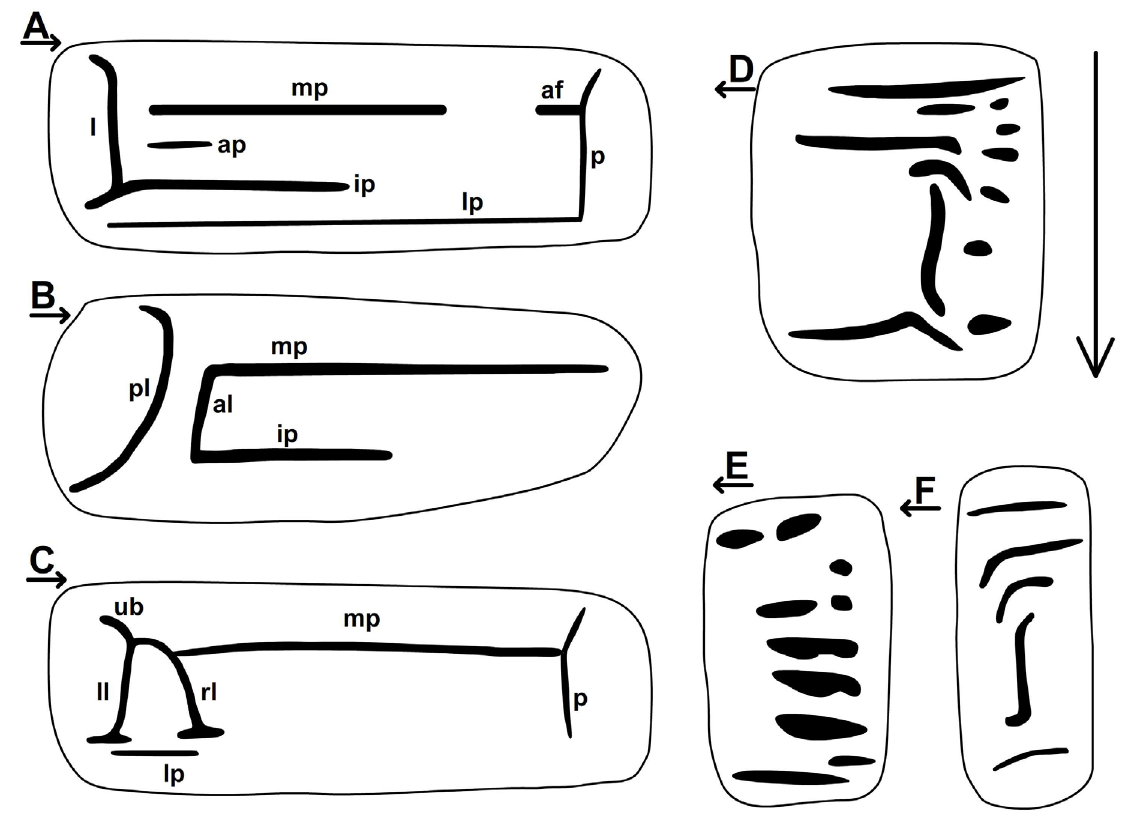
Fig. 1. Nomenclature of parietal (A–C) and palatal (D–F) lamellae and plicae of plectopylids. A . Chersaecia Gude, 1899 sp. with a single lamella. B . Chersaecia sp. with two lamellae. C . Plectopylis Benson, 1860 sp. D–E . Chersaecia spp. F . Plectopylis sp. The long arrow shows the order of counting of the plicae. Abbreviations: af = apertural fold; al = anterior lamella; ap = additional plica; ip = intermediate plica; l = lamella; ll = left leg; lp = lower plica; mp = main plica; p = peristome; pl = posterior lamella; rl = right leg; ub = upper branch. Arrows under the numbers indicate the direction of the